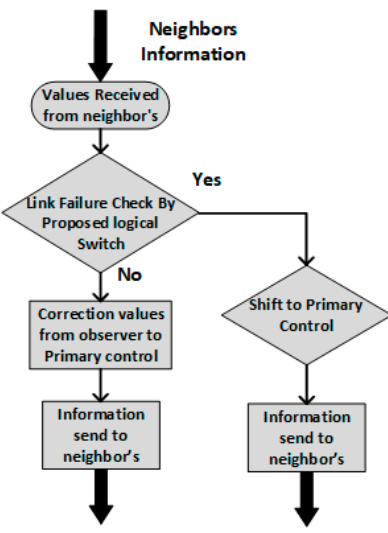
Figure 4. Voltage observer in the proposed secondary control.